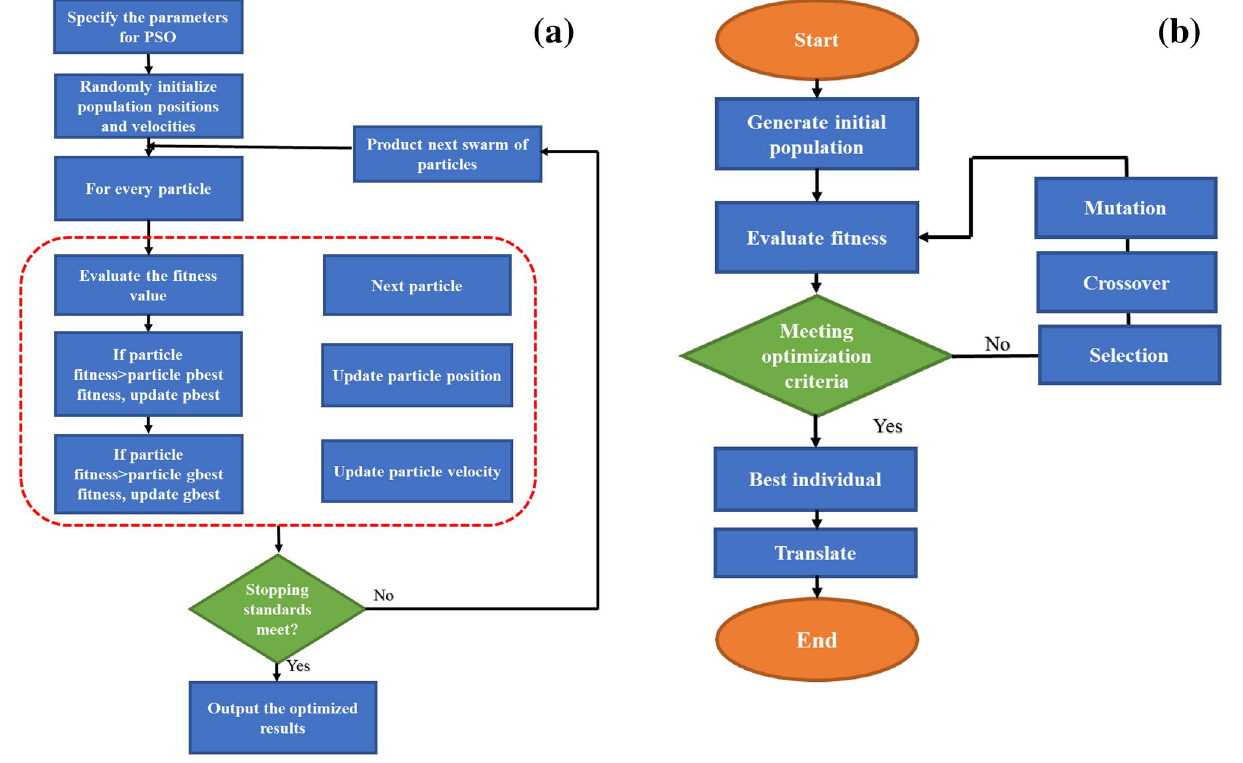
Figure 2. Scheme of the ( a ) PSO algorithm, ( b ) GA